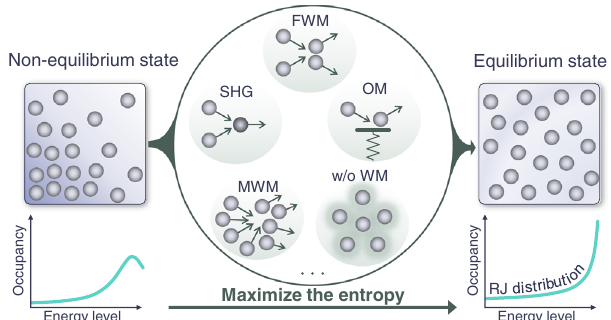
Fig. 1 | Conceptual illustration of thermalization in a nonlinear multimode optical system. Similar to thermalization in matter, the nature of the interaction forces (like forces between gas molecules) is irrelevant. Here, we show that light thermalization into a Rayleigh – Jeans (RJ) distribution can take place under a wide range of nonlinear conditions beyond the traditional four-wave mixing (FWM) paradigm. These include second harmonic generation (SHG), multi-wave mixing (MWM), optomechanical (OM) cascaded interactions between optical and mechanical modes, and even scenarios where the system cannot be described by any wave mixing expansion (w/o